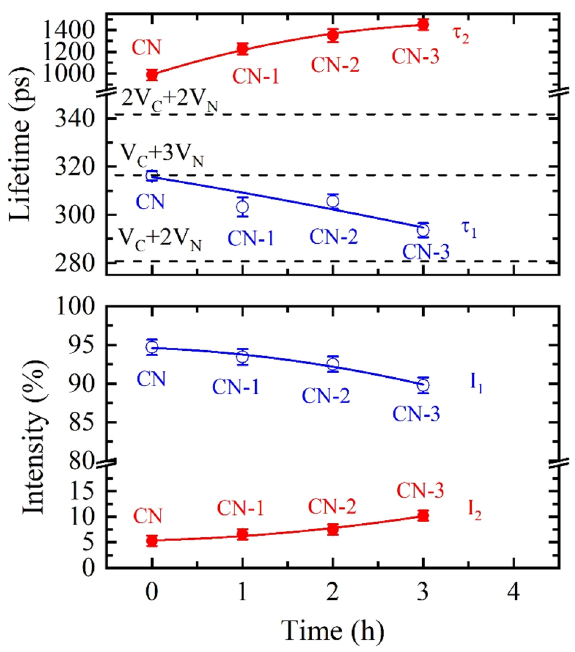
Figure 15. Dependence of lifetimes and intensities of individual components on annealing time in air 33 . Horizontal dashed lines show calculated lifetimes for different types of